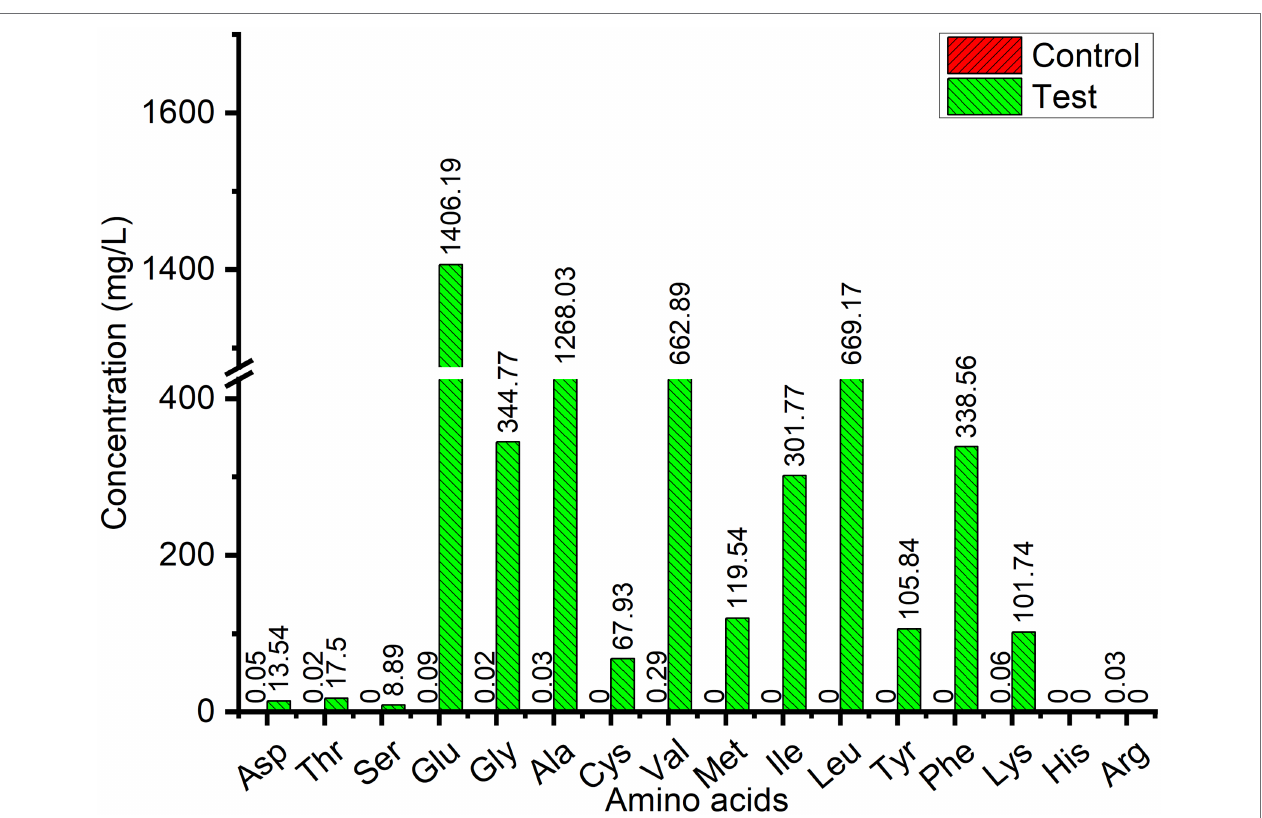
FIGURE 4 | Free amino acid contents in wool fiber waste fermented broth by Lysobacter brunescens YQ20. Control, autoclaved feather medium without inoculum; Test, fermentation by Lysobacter brunescens YQ20. The control value was too low to